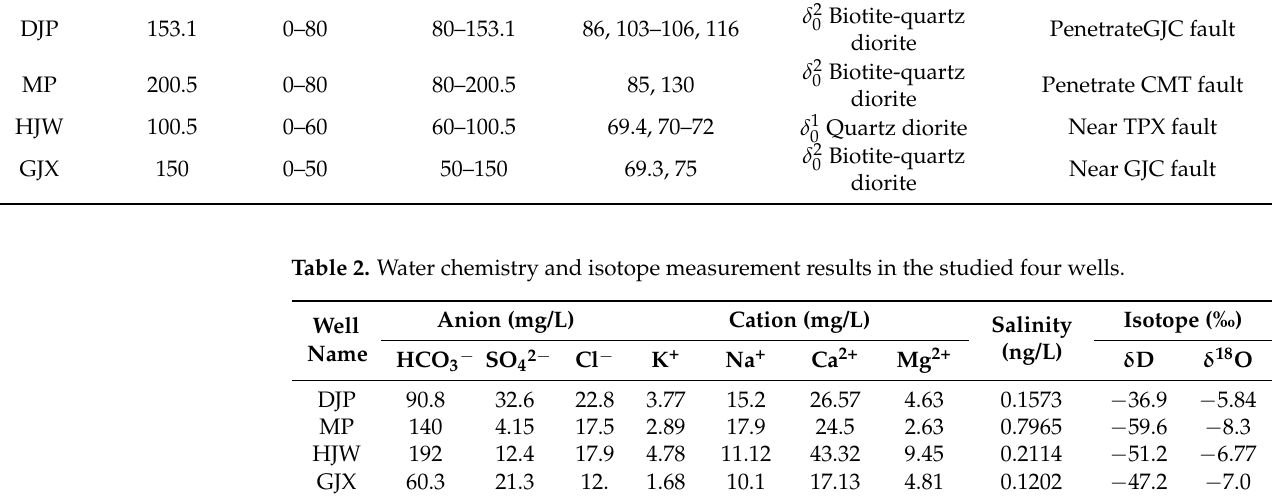
Table 1. Basic information regarding the four wells around the Three Gorges Dam.